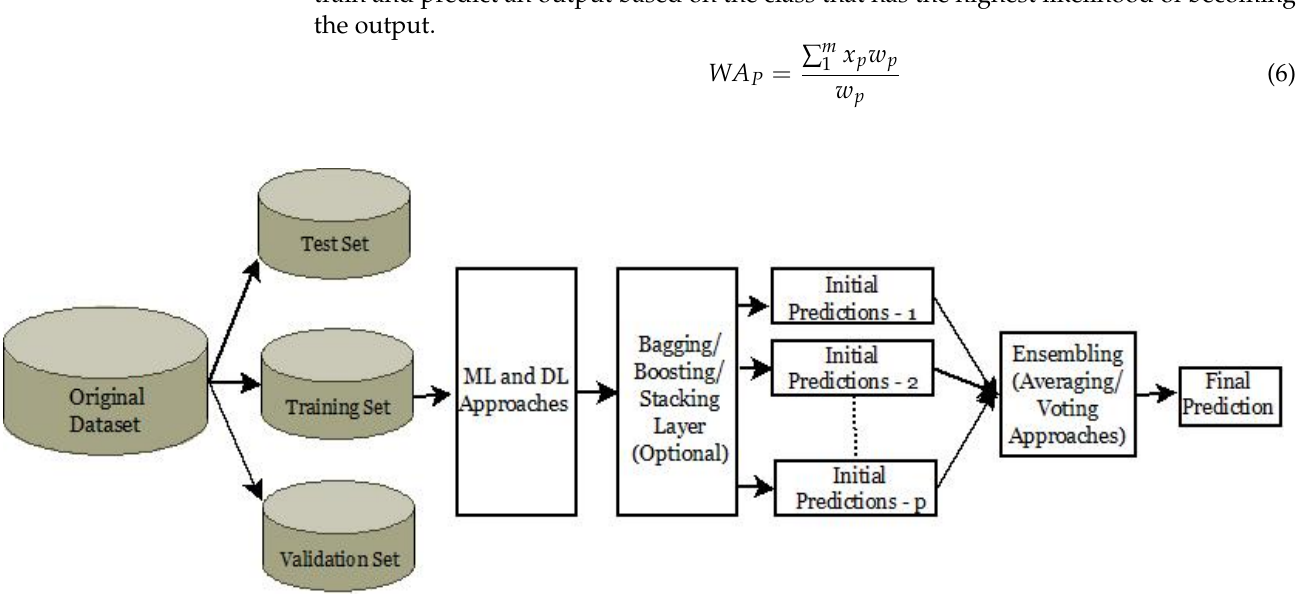
Figure 2. Ensembling of ML and/or DL